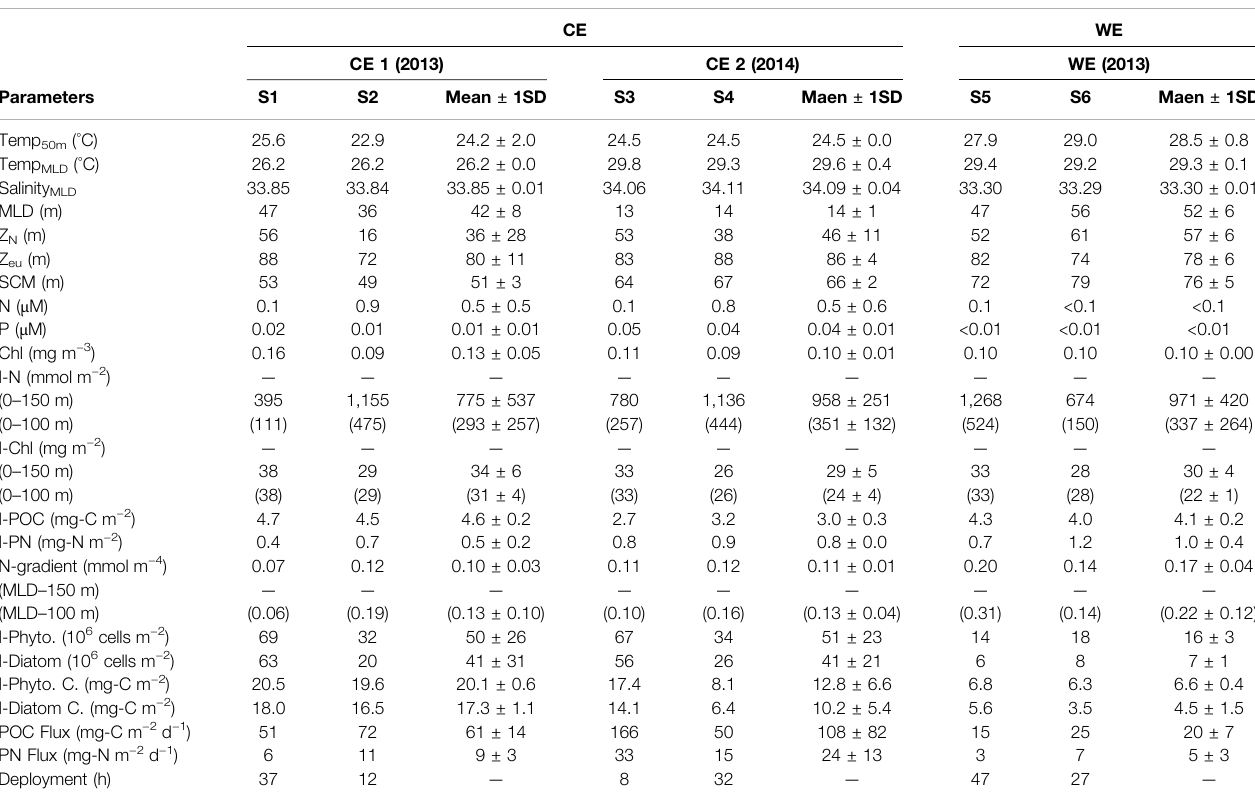
TABLE 1 | Summary of given parameters (mean ± SD), including temperatures at 50 m water depth (Temp 50m ); mean temperature and salinity values of the mixed layer (Temp MLD and Salinity MLD ); mixed layer, nitracline, euphotic zone and subsurface Chl maximum depths, respectively (MLD, Z N , Z eu and SCM); surface water concentrationsofN,PandChl,respectively(N,PandChl);watercolumninventories(0 – 150and0 – 100 m)ofNandChl(I-NandI-Chl);inventoriesintheupper150 mofPOC and PN(I-POC andI-PN);vertical gradients(MLD – 150andMLD – 100 m) ofN(N-gradient);watercolumn phytoplanktonand diatominventories intheupper 100 m(I-Phyto. andI-Diatom);watercolumnphytoplanktonanddiatomcarboninventoriesintheupper100 m(I-Phyto.C.andI-DiatomC.);export fl uxesofPOCandPNat150 mdepth (POC fl ux and PN fl ux); the periods of deployment; at respective stations of the CEs and the WE relevant to this study. CE